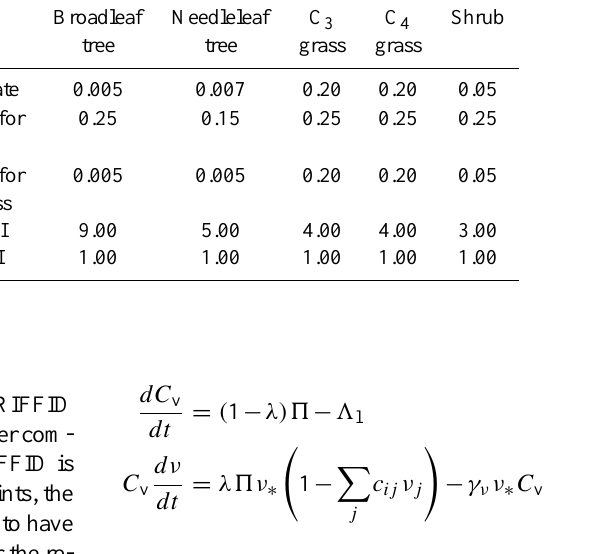
Table 6. Default values of PFT-specific parameters for TRIFFID. Broadleaf Needleleaf C 3 C 4 Shrub tree tree grass grass γ v (360days) − 1 Disturbance rate 0.005 0.007 0.20 0.20 0.05 Turnover rate for 0.25